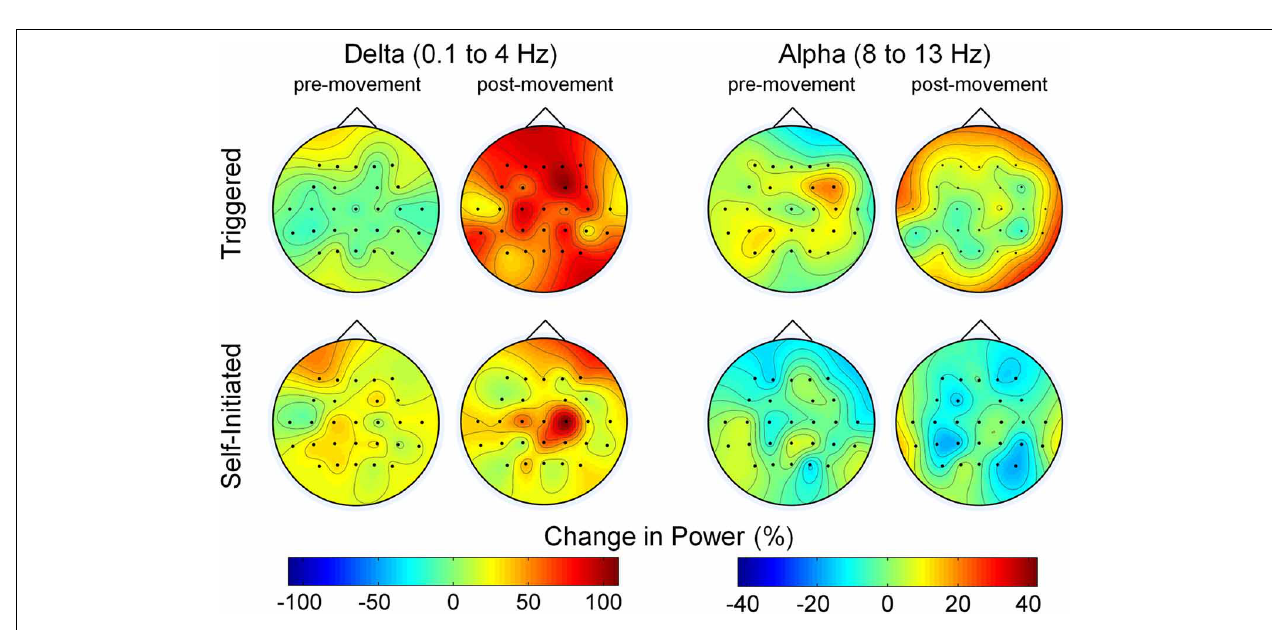
FIGURE 4 | Scalp maps of the change in power compared to rest during pre- and post-movement epochs. The two sets of maps show the average change in delta and alpha band power across all electrodes and subjects